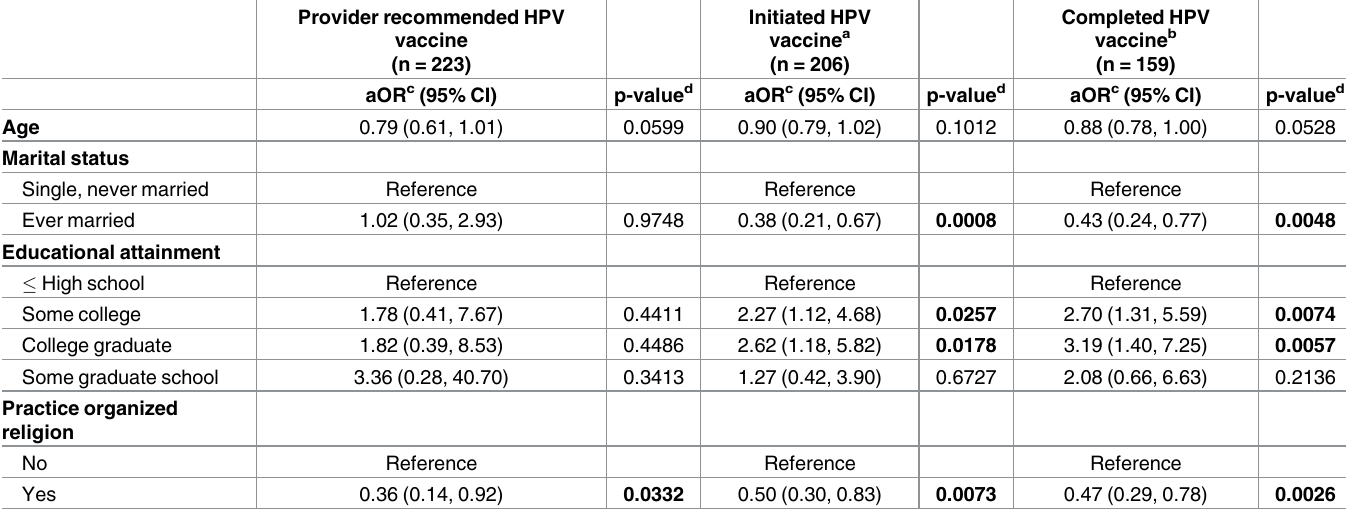
Table 4. Multivariable logistic regression for HPV vaccine